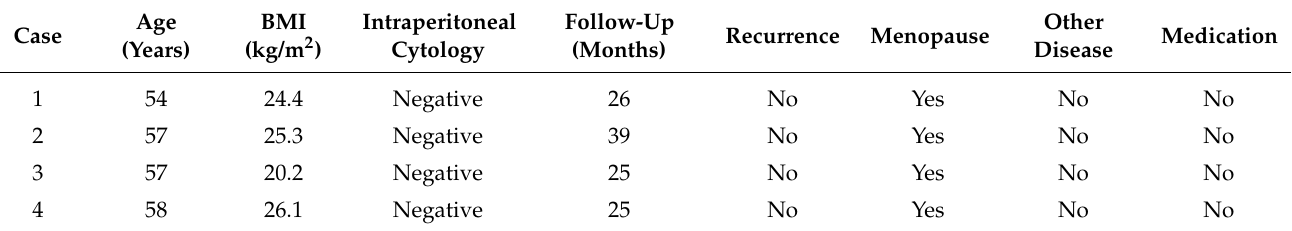
Table 2. Characteristics of four patients with atypical endometrial